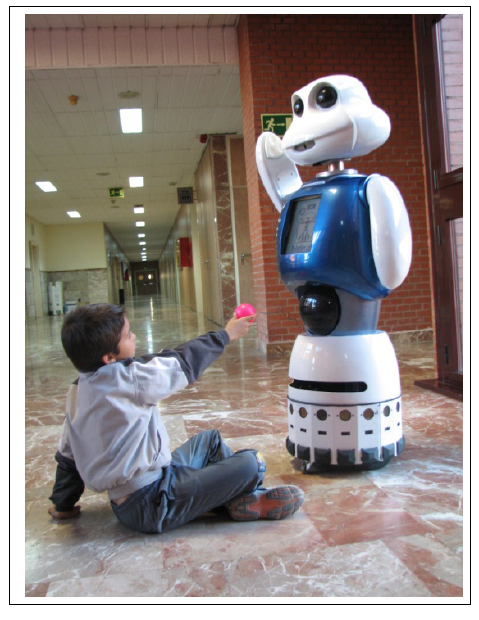
Figure 1. Our social robot,